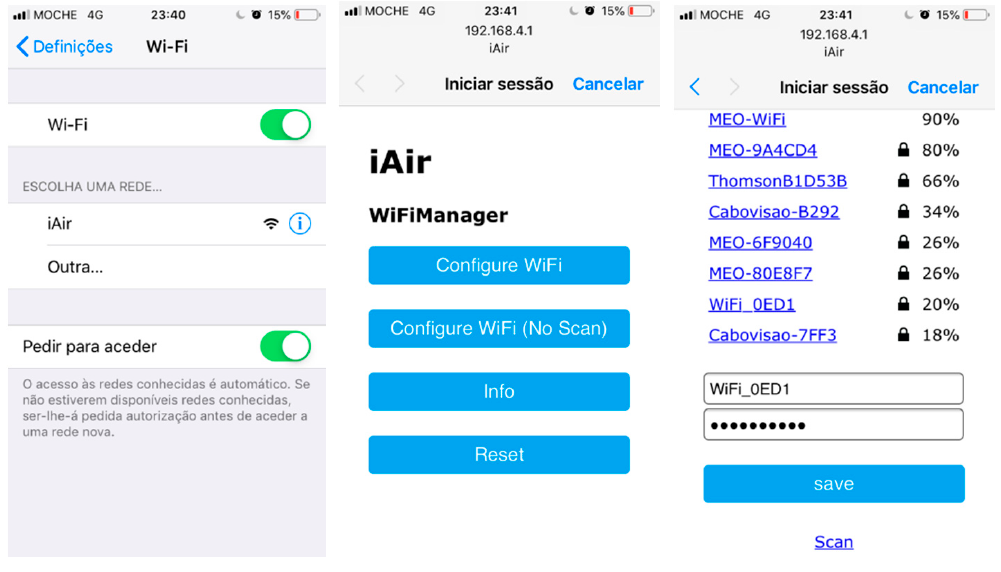
Figure 9. Wi-Fi Figure 9. Wi-Fi configuration.